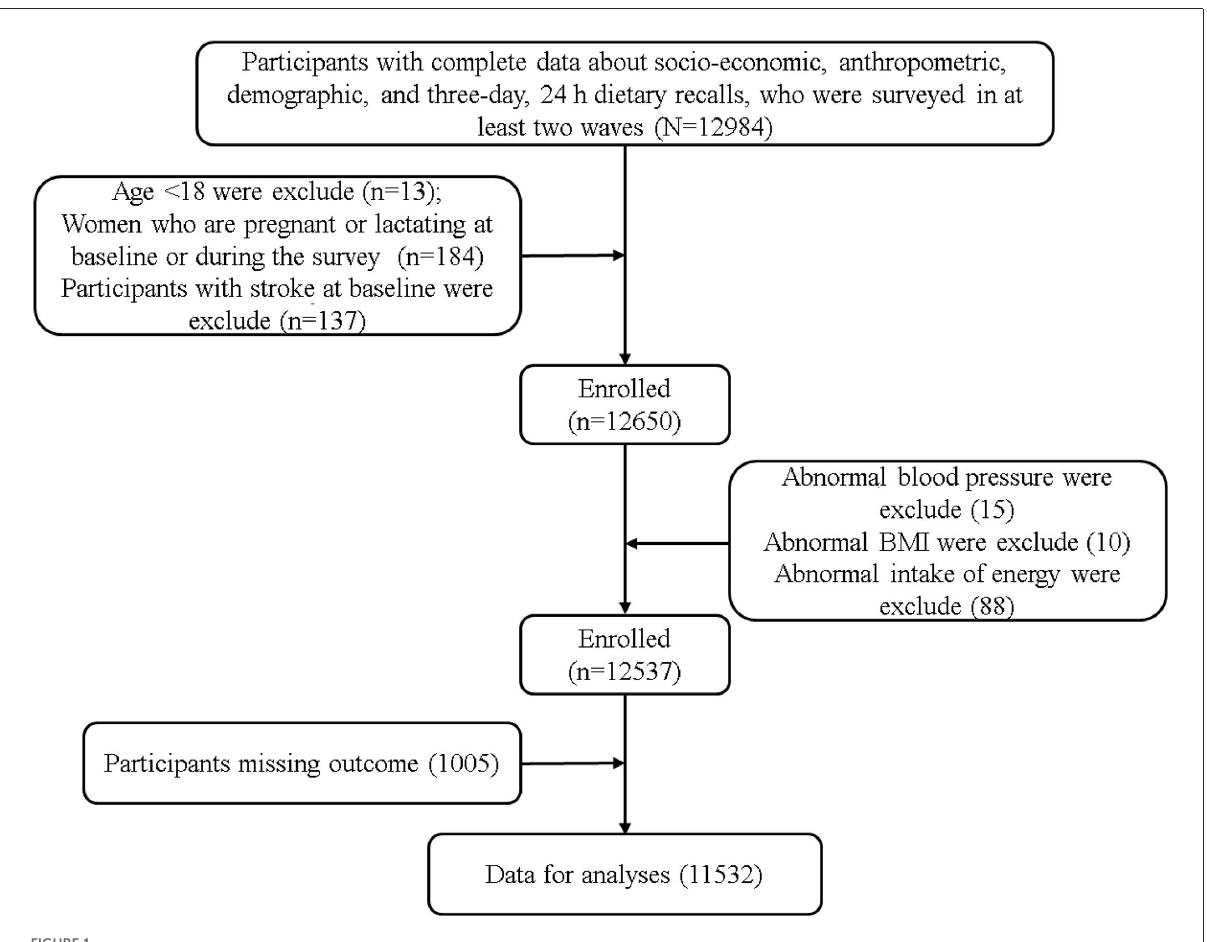
FIGURE1 Flow chart for inclusion and exclusion of research